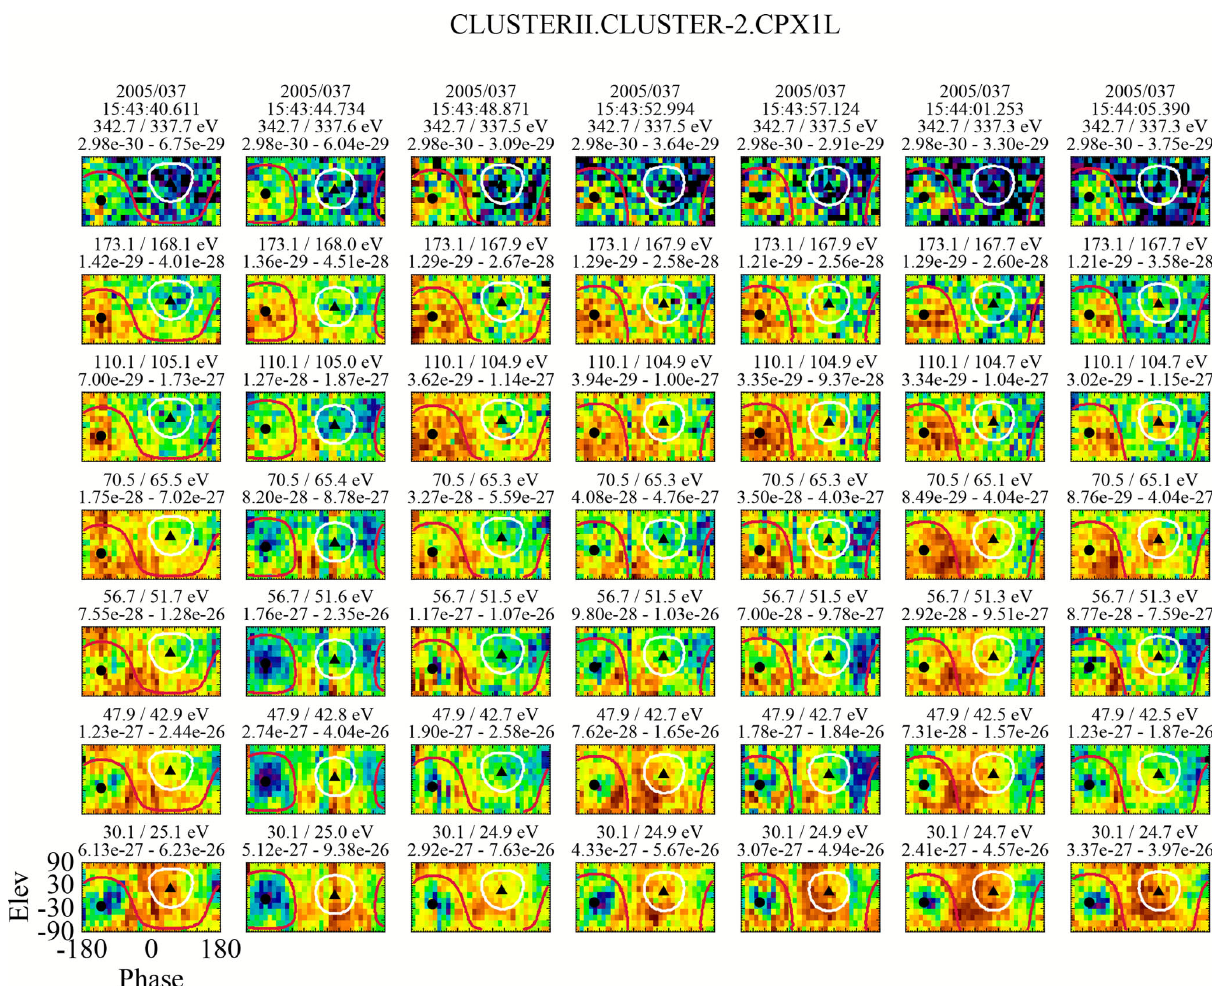
Figure 15. Characteristics of seven sequential eVDFs shown through φ – θ plots, which span the arrows shown in the center plot of Fig. 14. Recall that the location of the strahl, when present, is expected within the white circle, while the return electrons are expected within the red